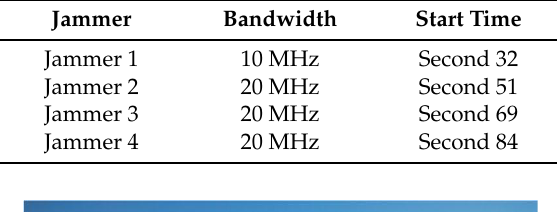
Figure 17. The two jamming scenarios used in the following experiments.